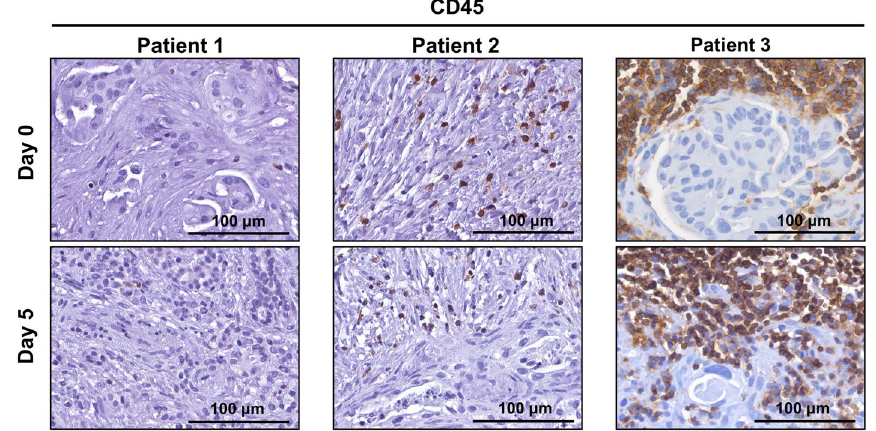
Figure 6. CD45-positive lymphocytes remain viable for 5 days in human patient derived pancreatic ductal adenocarcinoma tumour explants. Immunohistochemistry was performed for lymphocyte marker CD45 on tumour explants from patients 1–3 at day 0 and day